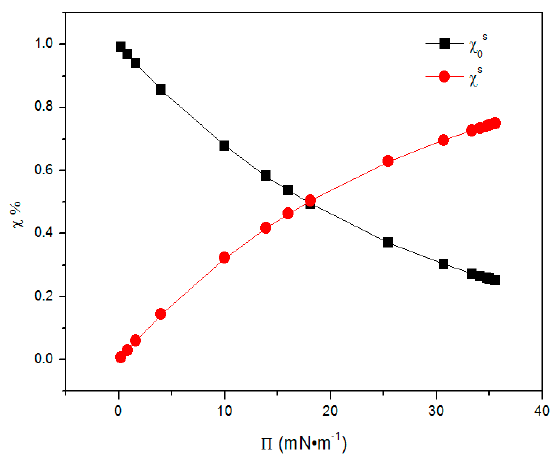
Figure 4. Dependence of the molar fraction of solvent and mPEG-maleic rosin copolymer.